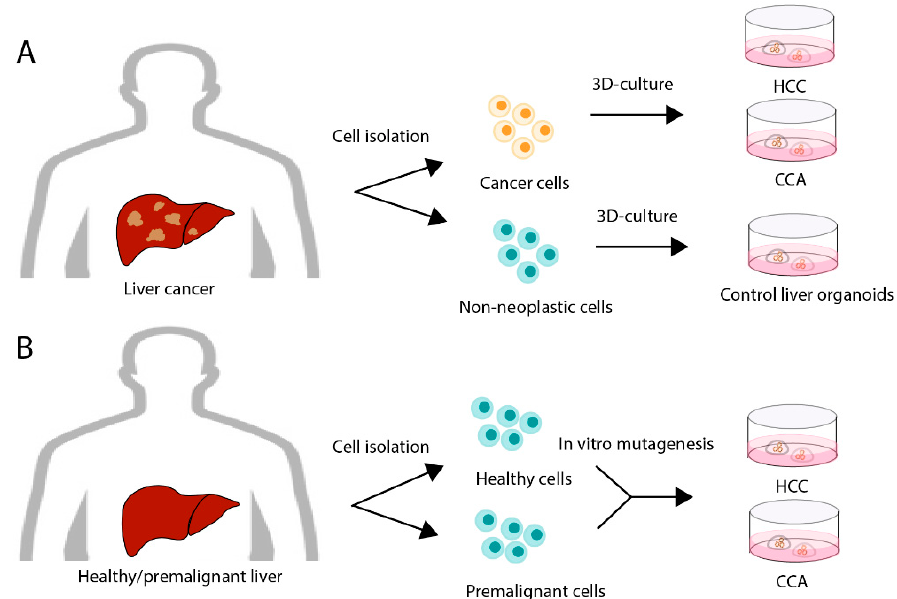
Figure 1. Generation of human primary liver cancer organoids. ( A ) Primary liver cancer organoids can be generated from neoplastic tissue via cell isolation. Paired non-neoplastic tissue can be obtained for control liver-derived organoids of the same patient. ( B ) Alternatively, liver tissue from healthy individuals or patients with liver disease at premalignant stages could be isolated and genetically modified in vitro to create various stages of primary liver cancer development. HCC: Hepatocellular carcinoma; CCA: Cholangiocarcinoma; 3D: Three-dimensional.